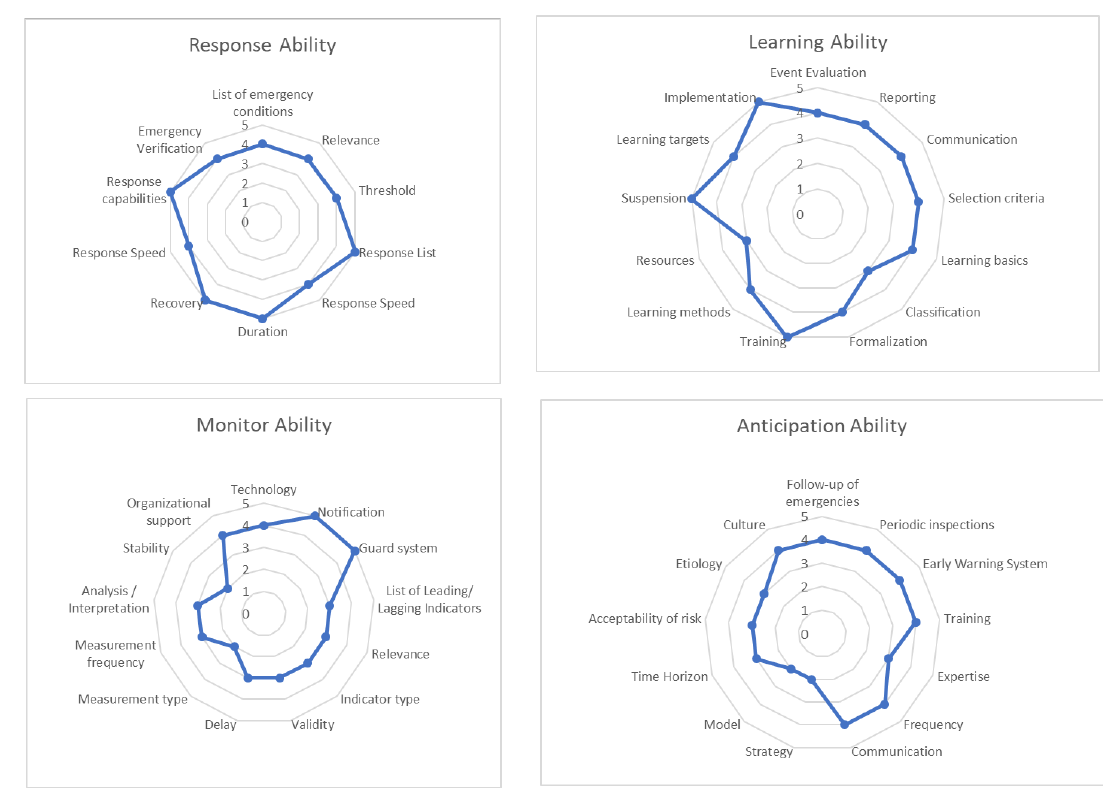
Figure 2. Ability analysis of safety resilience elements of the public company.